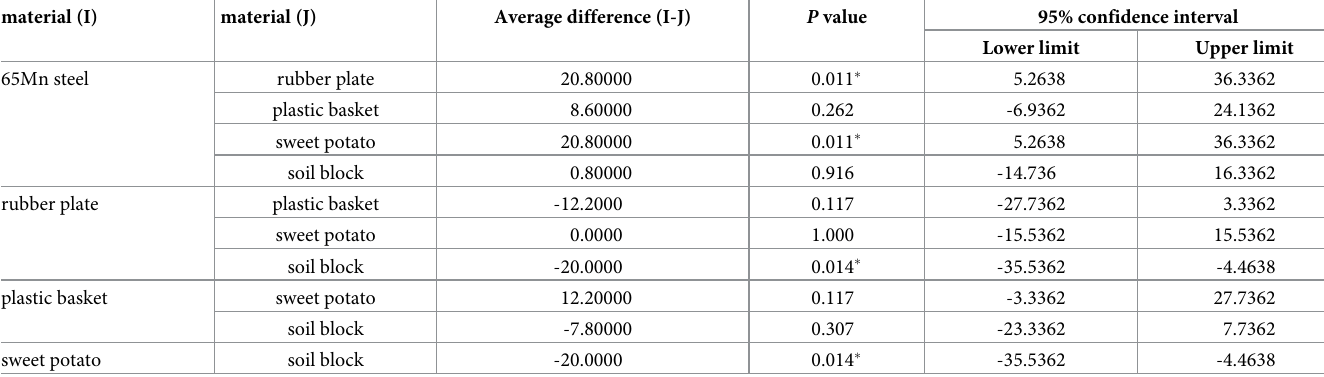
Table 7. Multiple comparisons of the influence of sweet potato collision materials on damaged